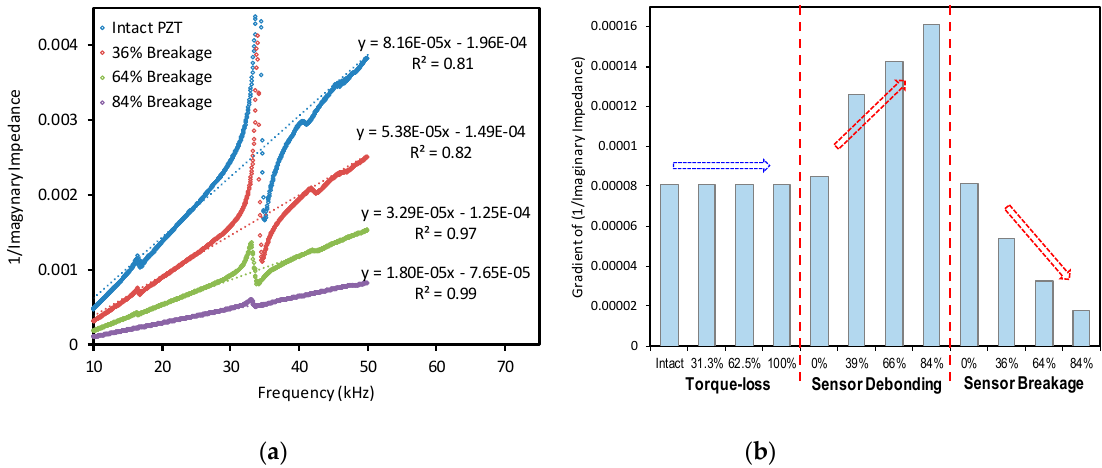
Figure 7. Sensor fault diagnosis using the slope of imaginary admittance: ( a ) linear approximation; ( b ) sensor fault diagnosis.